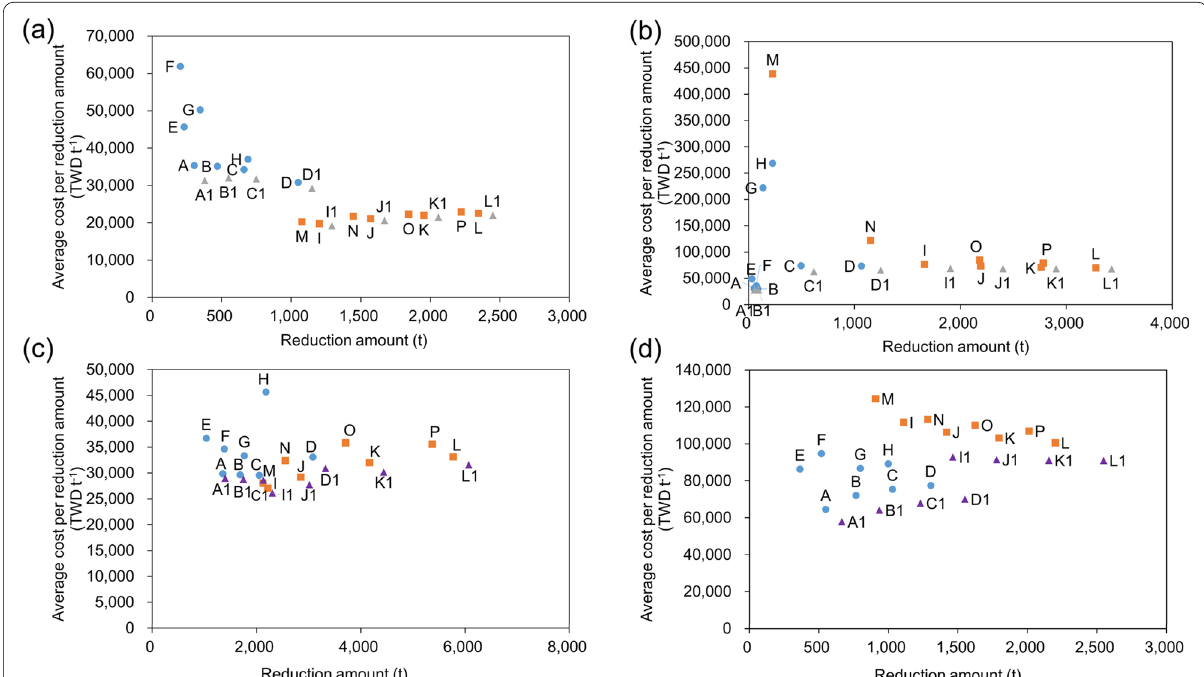
Fig. 4 Comparison diagram of the average cost per reduction amount and reduction amounts for ( a ) particulate matter (PM), ( b ) SO x , ( c ) NO x , and ( d ) volatile organic compounds (VOCs) in each simulation scenario. Note: 1 USD ≒ 32